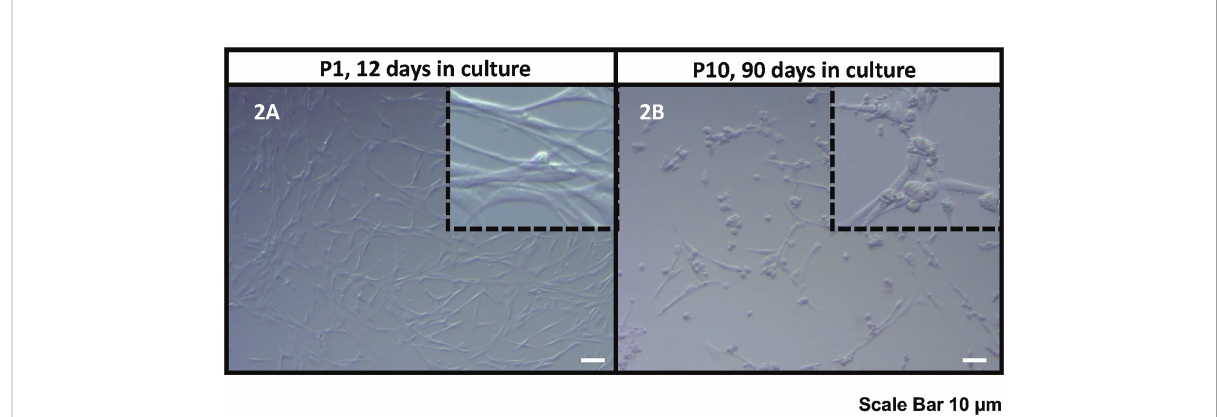
FIGURE 2 Bright fi eld microscope images of the human KS testicular cells in culture at passage 1, 12 days in culture (A) and passage 10, 90 days in culture (B) . As it was also reported previously (30, 32, 33), the current culture system includes both spermatogonia and testicular somatic cells. Somatic